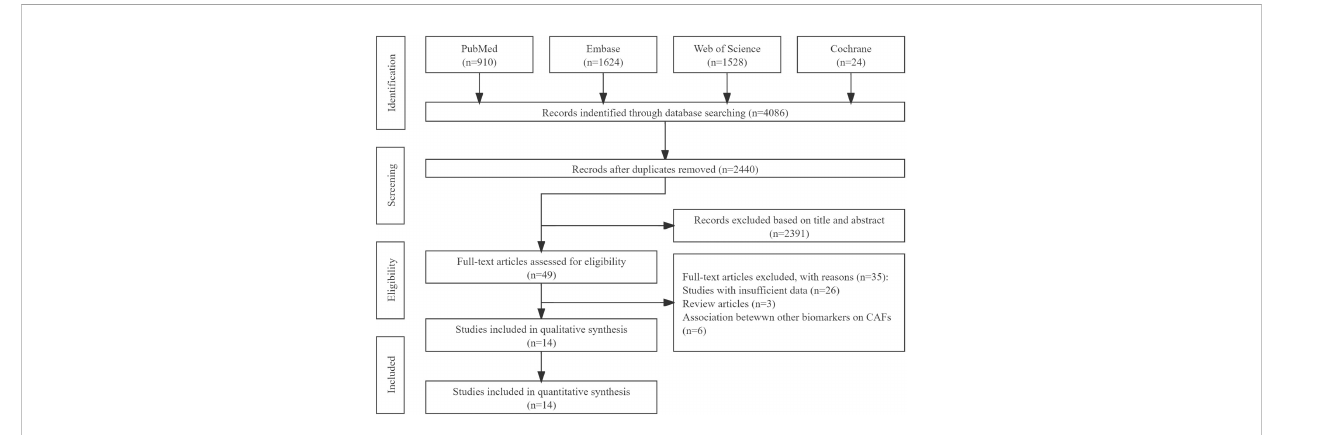
FIGURE 1 PRISMA fl ow diagram for study selection. CAF, cancer-associated fi